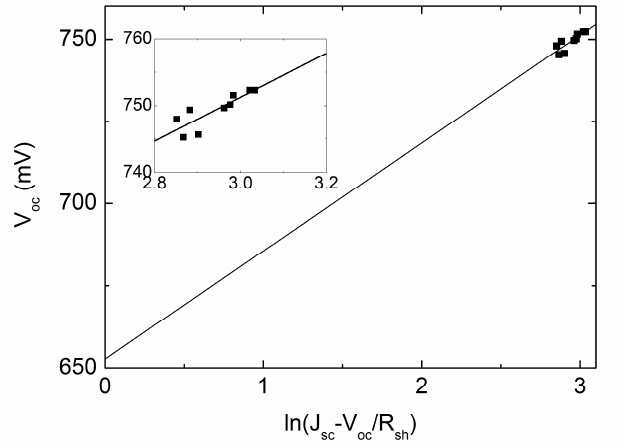
Figure 2. V oc versus ln( J SC – V OC / R sh ) for extraction of n and J 0 for cell #1. The Inset is an expanded view for the dotted part.